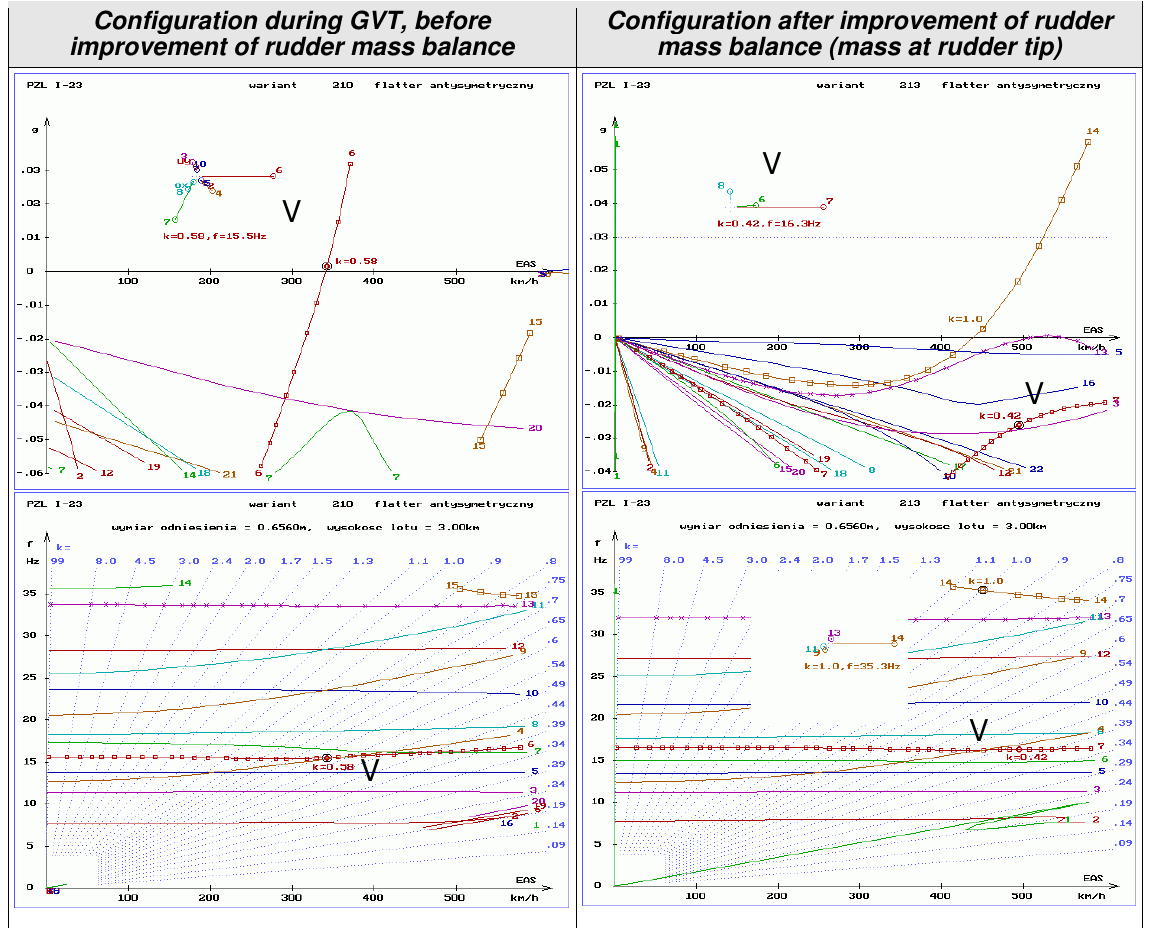
Fig 2. Results of anti-symmetric flutter calculation of I-23 airplane. The modal structural damping coefficients were not included